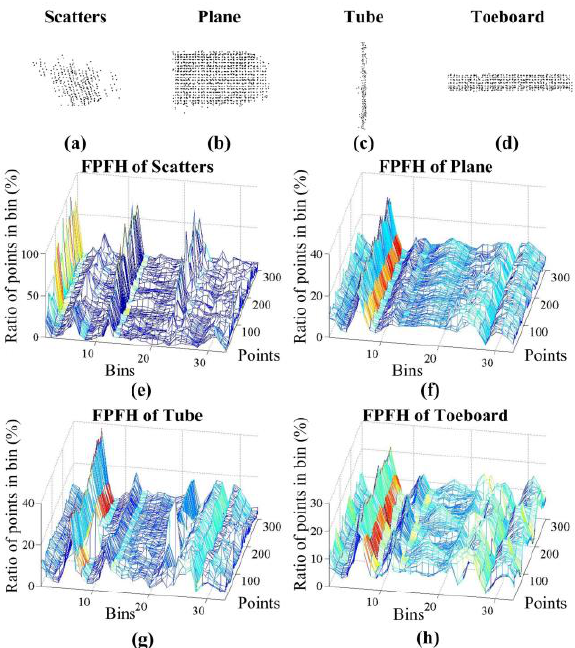
Figure 10. Different kinds of objects (up) and their FPFH (down), a) and e) scatters, b) and f) plane, c) and g) tube, d) and h) toeboard.